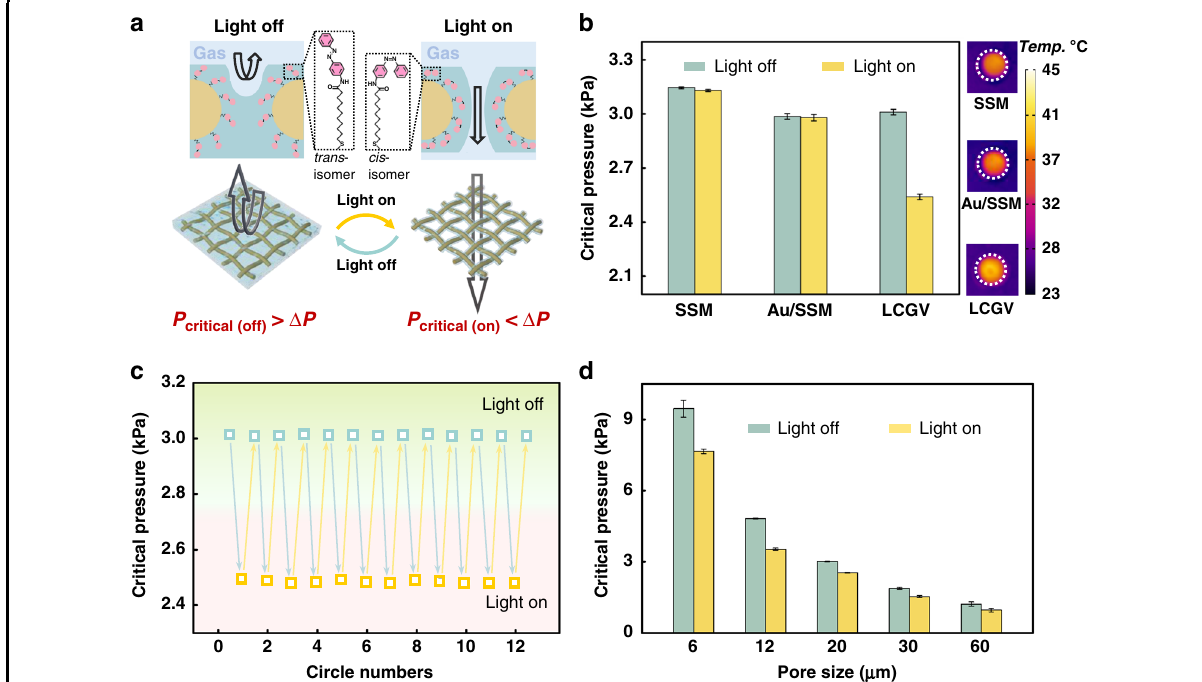
Fig. 3 The non-thermal effective light-responsive gating performance of the LCGV system. a Schematic illustration of the molecular photoswitch photoisomerization and gating liquid recon fi guration for light-regulated gas transport. b Critical pressures of different liquid gating systems with or without UV irradiation, respectively (left). The infrared images and central temperature of different liquid gating membranes when transporting gas under UV irradiation (right). c Critical pressures for gas through LCGV system during alternative irradiation cycles. d Critical pressures for gas through LCGV systems with different substrate pore